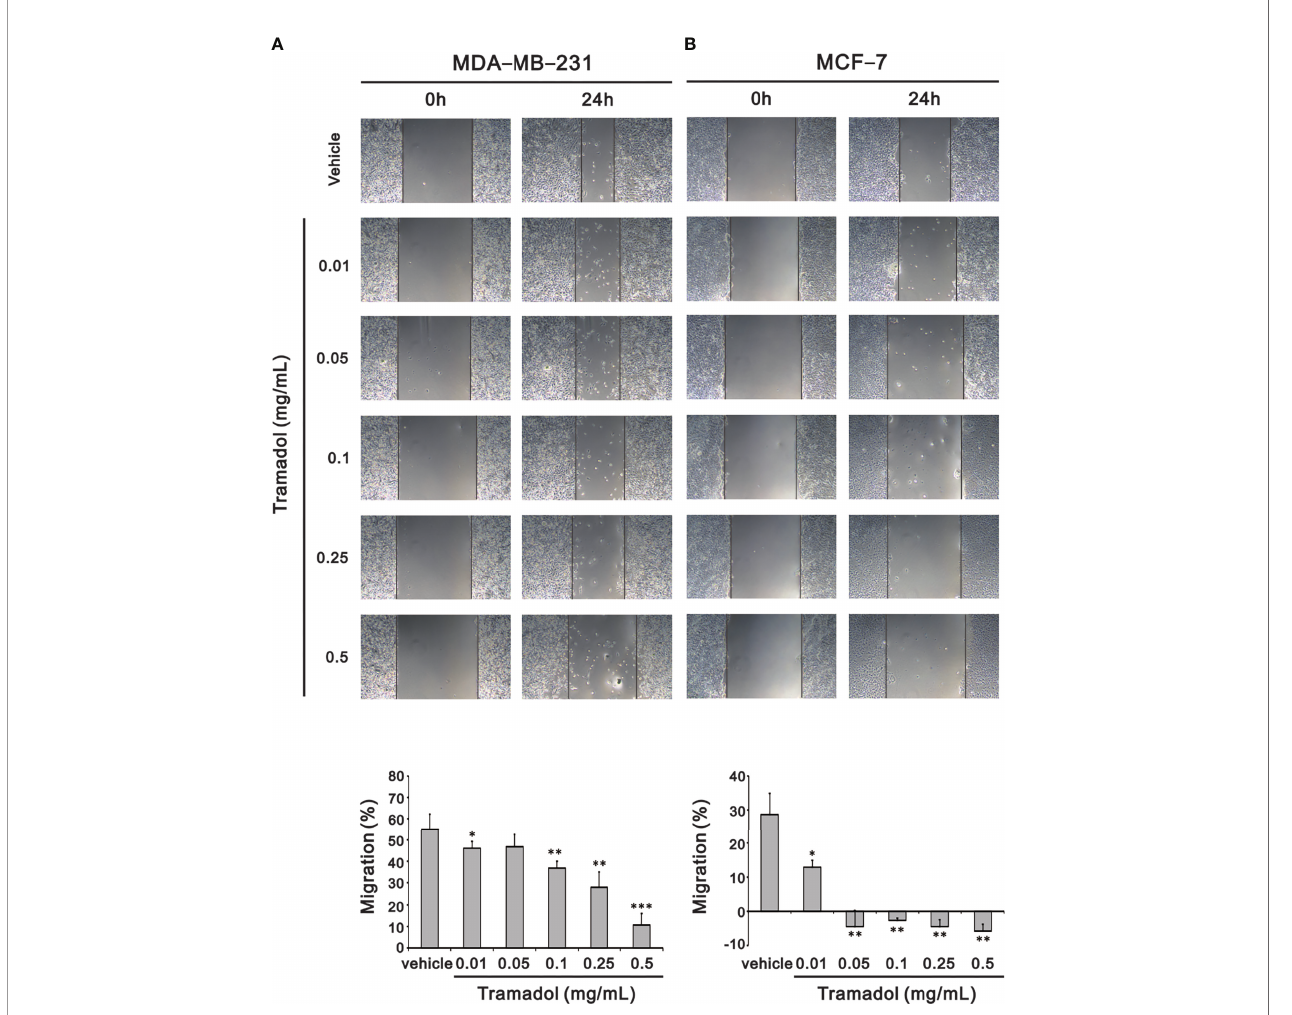
FIGURE 2 | Analysis of the effect of tramadol on the cell migration of human breast cancer cells in a wound-healing assay. (A, B) MDA-MB-231 and MCF-7 cells were treated with tramadol (0, 0.01, 0.05, 0.1, 0.25 and 0.5 mg/mL) for 24 h. Quanti fi cation of the migration area of untreated and tramadol-treated cells within 24 h using Image J Bars depict the mean ± SD of three independent experiments. * p < 0.05, ** p < 0.01 and *** p < 0.001 (Student ’ s t